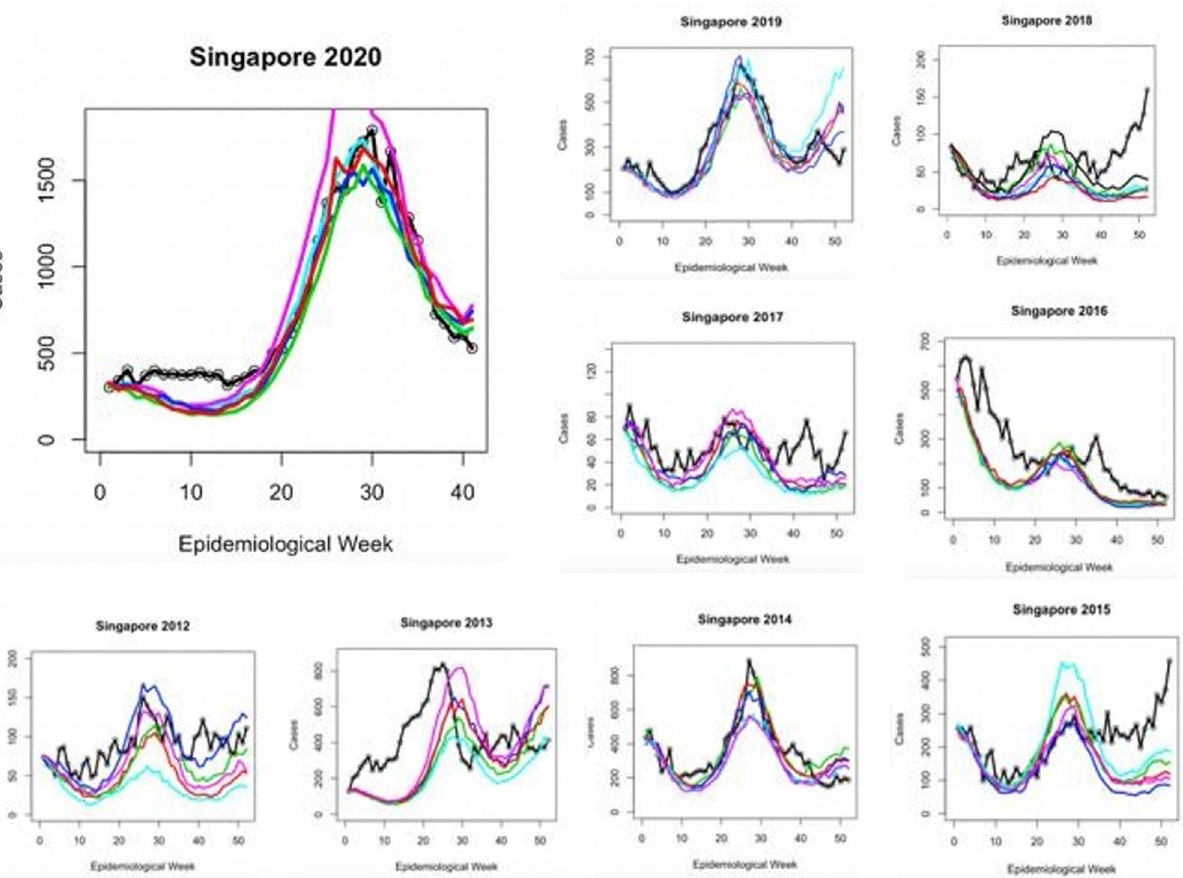
Figure 2. Graph exhibiting the results of seasonal model testing for Singapore yearly outbreaks. Colored lines represent five different forward simulation runs. Solid black line is the reported case count for each In Honduras, 51.5% of the population was estimated as susceptible in 2020, with 49.5% in 2019, 37.2% in 2018, 35.6% in 2017, 34.5% in 2016 and 35.3% in 2015. Seasonal model. The results from the seasonal model, incorporated with transmission rate estimates are presented in Table 3. Cross-correlation demonstrated that there was a 5 week lag effect in Singapore between an increase in transmission rate and a case increase, and a 6 week lag effect in Honduras. The results of five forward simulations per outbreak year using the produced seasonal beta regression are displayed in Figs. 2 and 3, and were statistically verified using Pearson’s correlation values (Table 4). On average, the seasonal model explained 98.5% of variance in Singapore 2020 cases, 83.1% in 2019, 7% in 2018, 41.8% in 2017, 44.3% in 2016, 42.4% in 2015, 74.2% in 2014, 14.2% in 2013 and 57.7% in 2012. Lag between forward simulations and the case report was shown to vary from − 6 to + 4 weeks. For Honduras case reports, the seasonal model explained 18.6% variance in 2020, 92.8% in 2019, 21.3% in 2018, 57.5% in 2017, 59% in 2016, 91% in 2015.